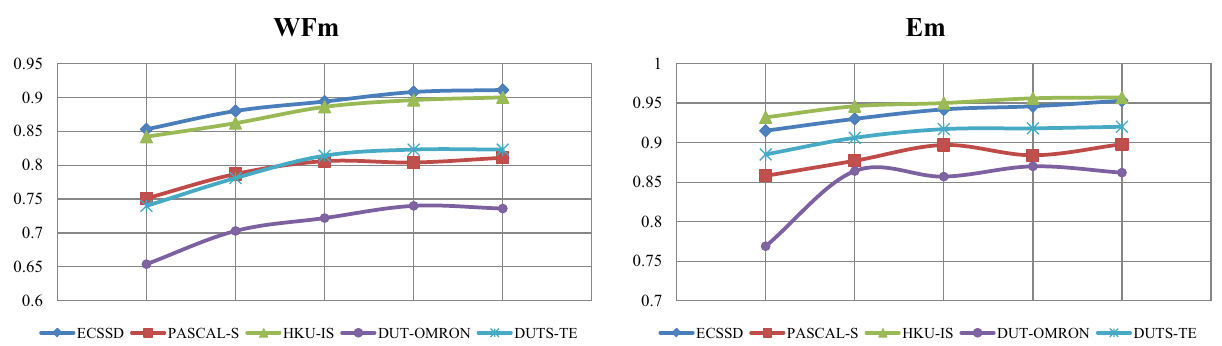
Figure 8. Ablation studies results of the proposed GSCINet method. The five points de- note “Backbone”, “Backbone+FPN”, “Backbone+AFSIM”, “Backbone+MSCAM+FPN”, and “Back- bone+MSCAM+AFSIM”,